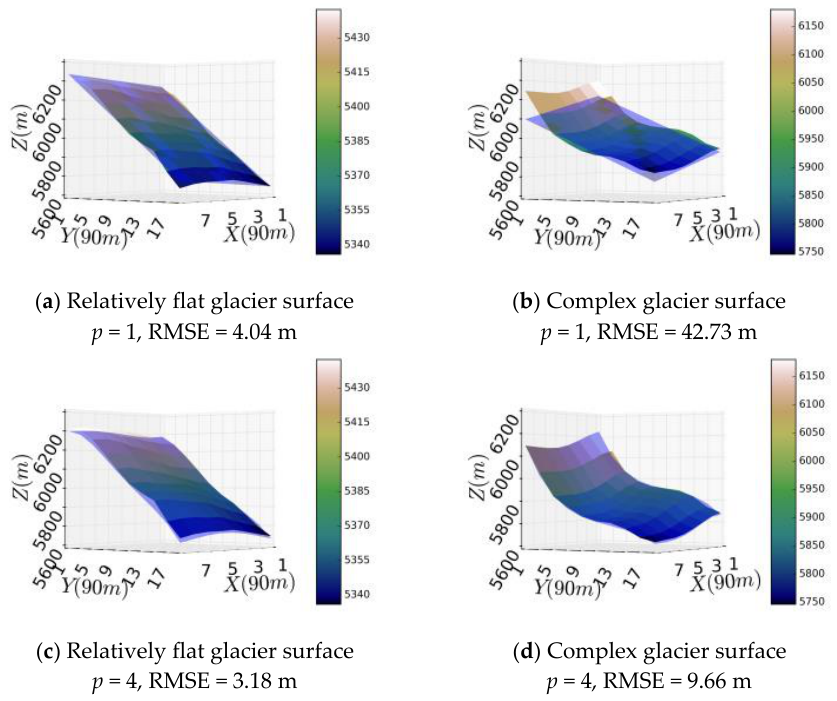
Table 2. The RMSE value (m) between fitted glacial surface and real glacial surface for the cases of polynomial fitting ( p = 4) and of planar fitting ( p = 1) over six glacial facets in the Himalayas.